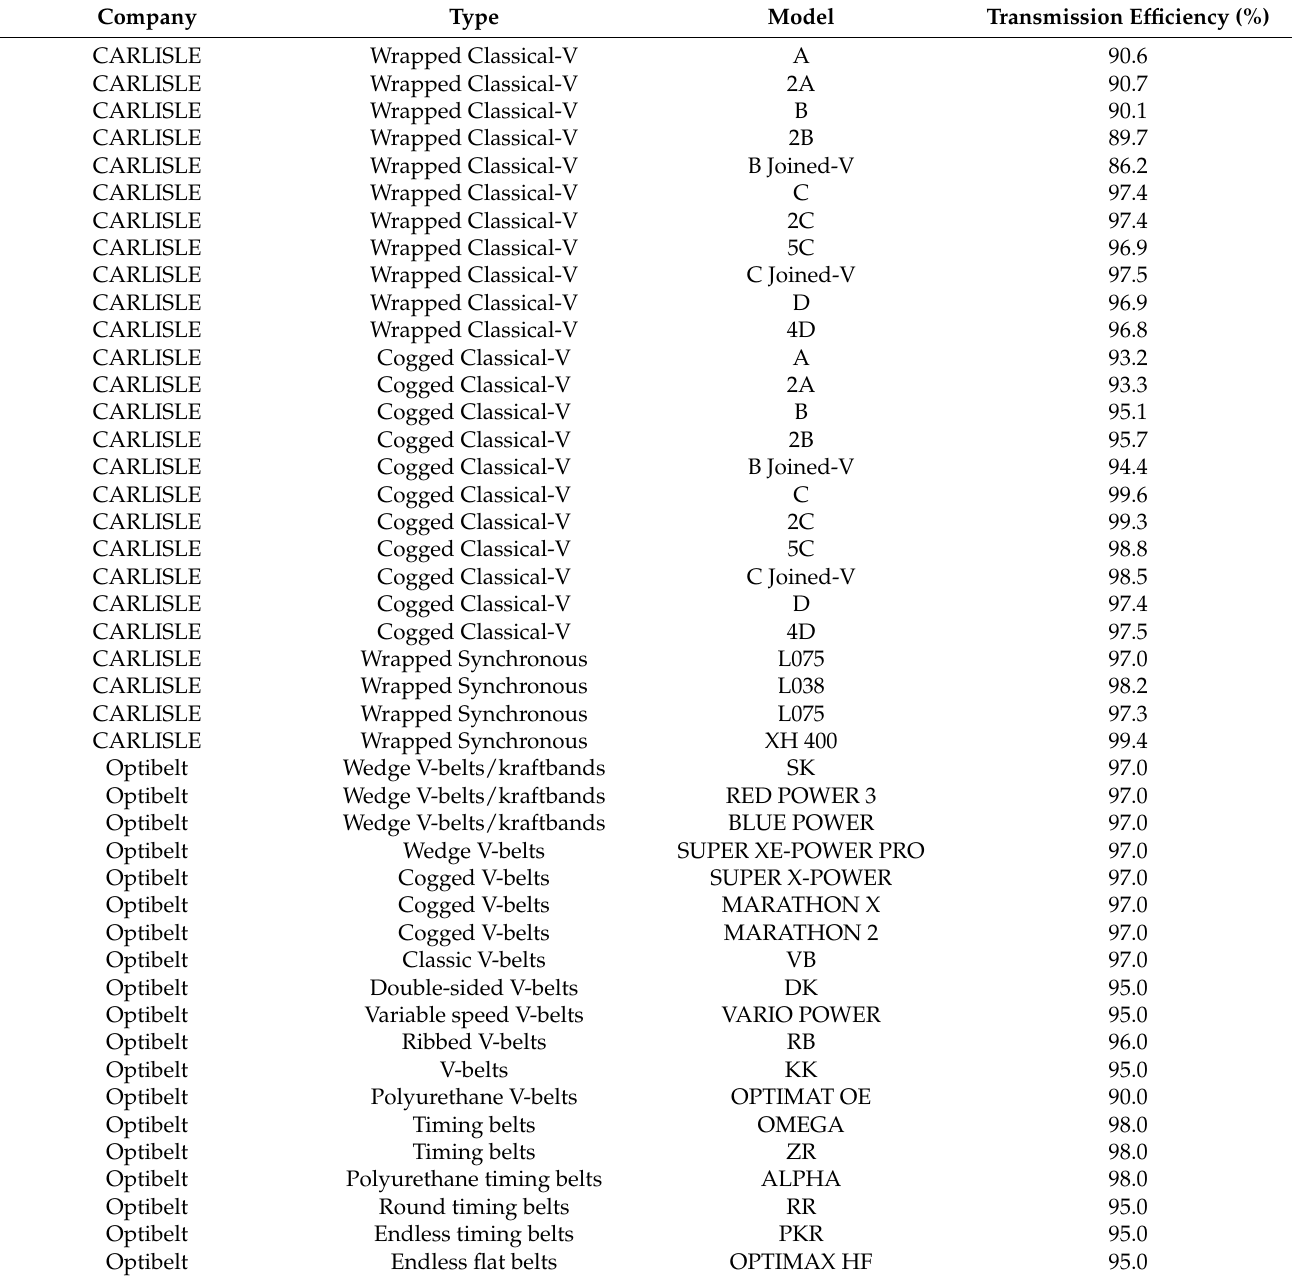
Table 3. Efficiency DB for each type of belt